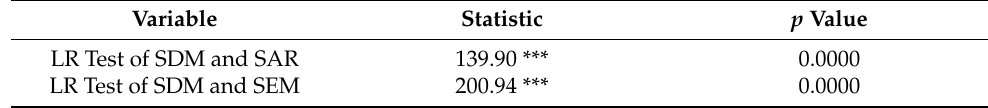
Table 5. LR test results (SAR/SEM/SDM).